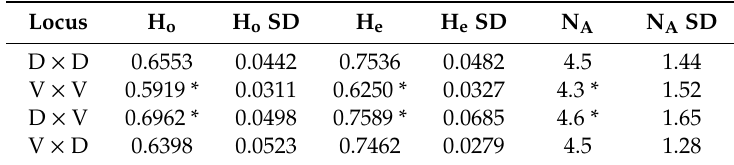
Table 6. Summary statistics of the genetic variation among the analyzed purebred and hybrid crosses of the Volga and Danube sterlet.